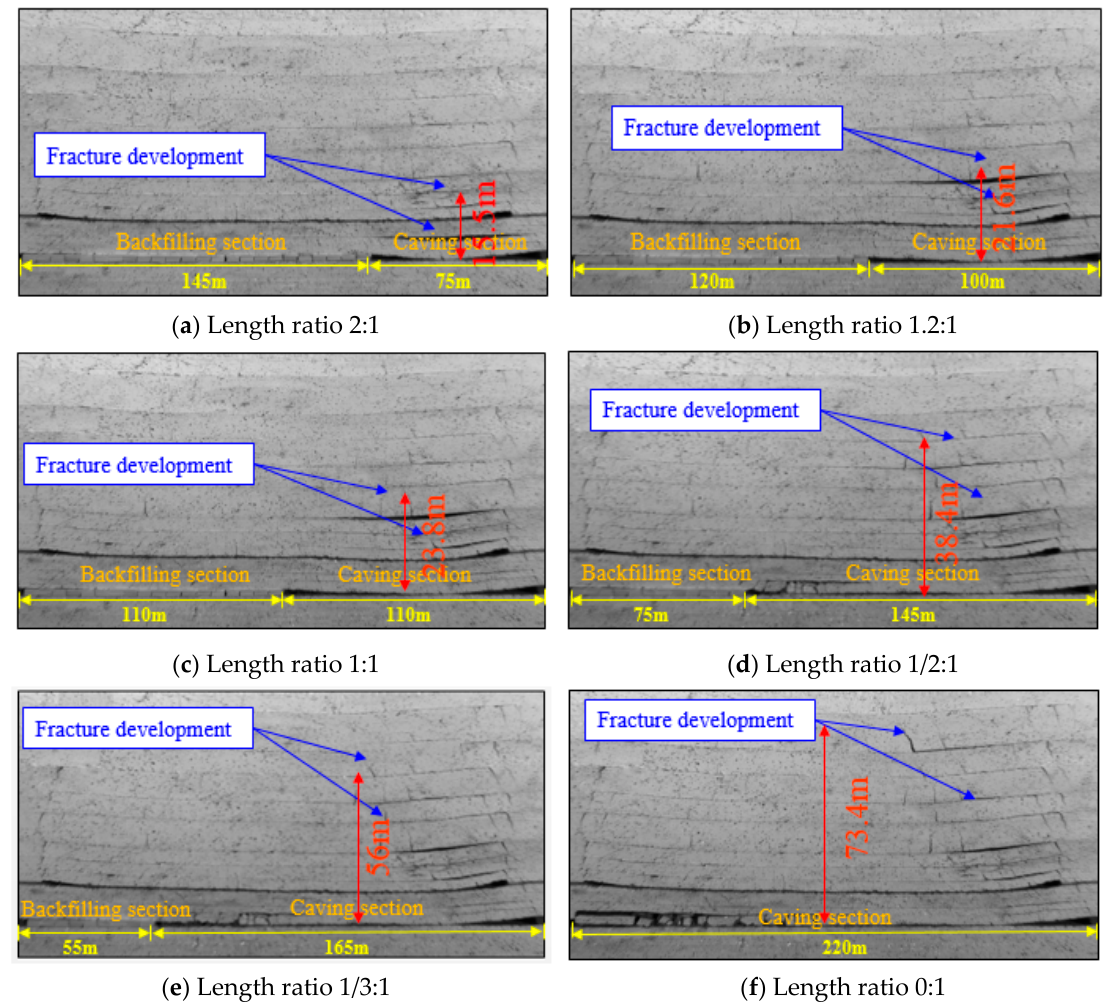
Figure 4. Features of overlying strata’s fracture development. (Note: Ratio ( a – f ) refers to the length ratio of the backfilling section and the caving section).